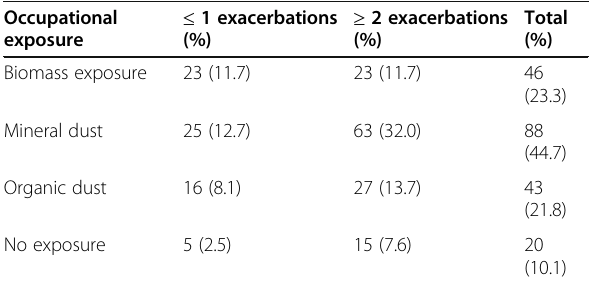
Table 8 Distribution of occupational exposure with number of exacerbations